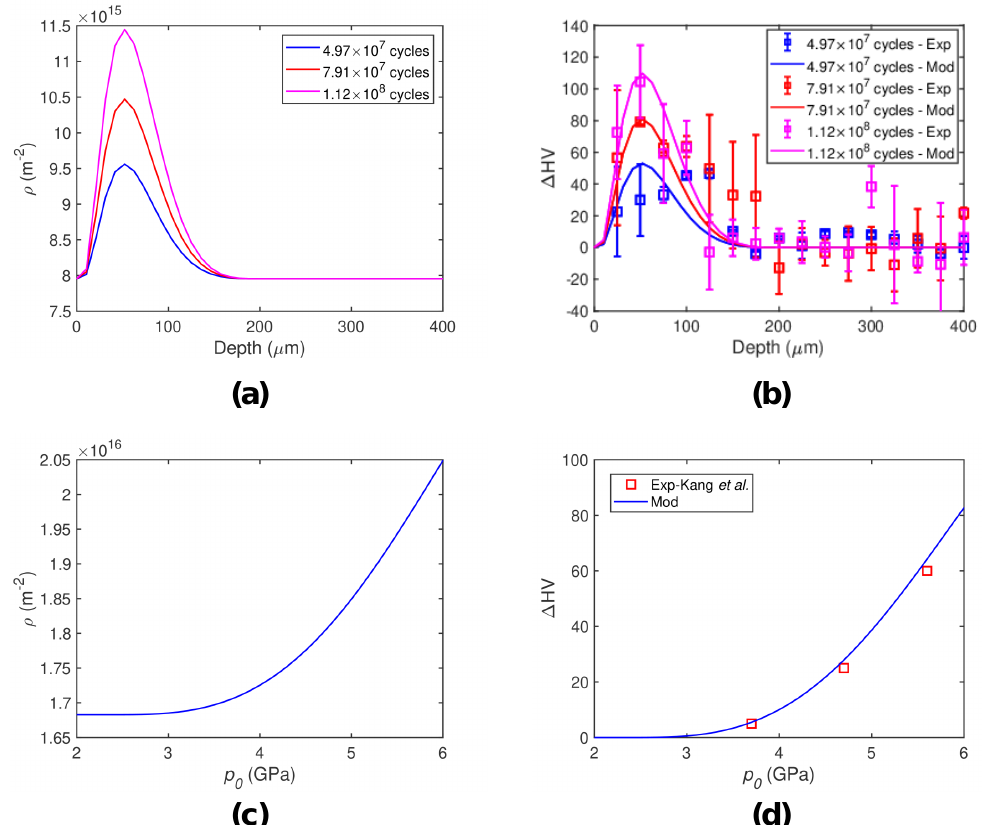
Figure 5. Modelling results: ( a ) calculated evolution of dislocation density along depth with respect to N ; ( b ) predicted hardness profiles compared with experiment; ( c ) calculated evolution of dislocation density at the peak position with respect to p 0 for the research by Kang et al. [8]; ( d ) predicted evolution of hardness at the peak position compared with